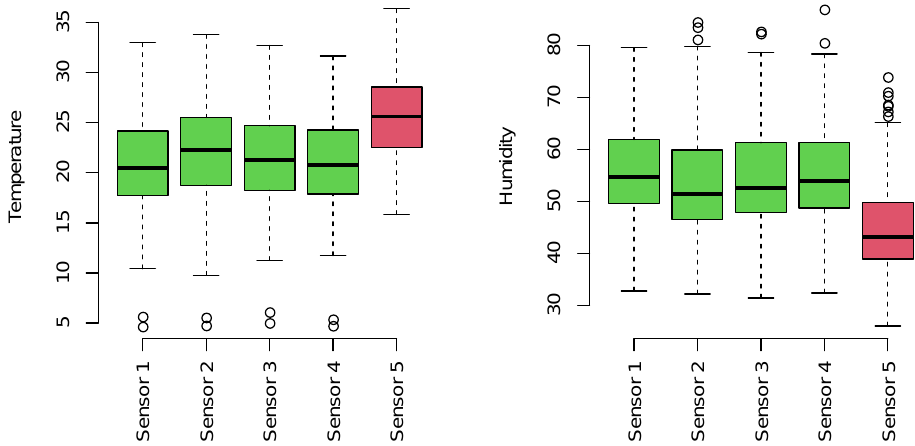
from the same sensors (Sensor 1, Sensor 4 and Sensor 5) for the green cluster and Sensor 2 and Sensor 3 for the red cluster.